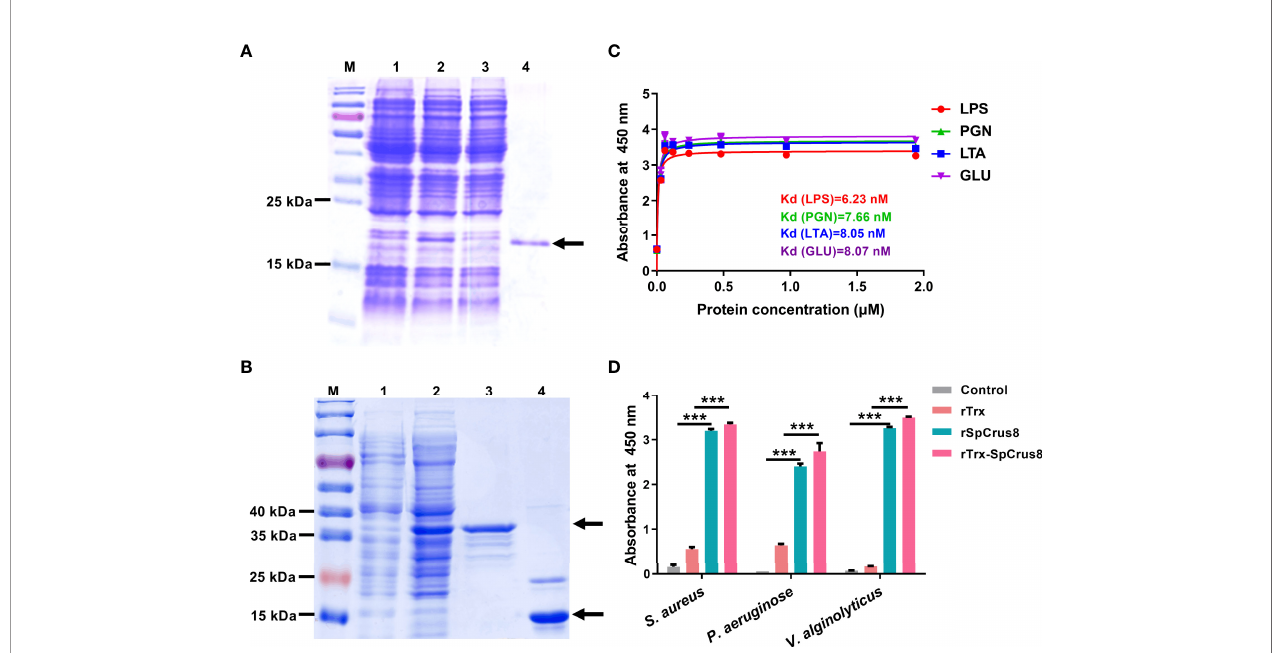
FIGURE 3 | Recombinant SpCrus8 expression and binding activity. Expression and puri fi cation of recombinant SpCrus8. (A) Lane M: protein molecular standard; lane 1: E . coli BL21 (DE3) containing recombinant vector (pET-30a-SpCrus8) before induction; lane 2: E . coli BL21 (DE3) containing recombinant vector (pET-30a- SpCrus8) after induction by 0.5 mM isopropyl- b -D-thiogalactopyranoside (IPTG); lane 3: fl ow-through during protein puri fi cation; lane 4: puri fi ed rSpCrus8. (B) Lane M: protein molecular standard; lane 1: E . coli BL21 (DE3) containing recombinant vector (pET-32a-SpCrus8) before induction; lane 2: E . coli BL21 (DE3) containing recombinant vector (pET-32a-SpCrus8) after induction by 0.5 mM IPTG; lane 3: puri fi ed rTrx-SpCrus8. lane 4: puri fi ed rTrx. (C) Binding activity of rSpCrus8 to PAMPs (LTA for lipoteichoic acid, LPS for lipopolysaccharide, PGN for peptidoglycan, GLU for glucan). (D) Binding activity of rSpCrus8, rTrx-SpCrus8 and rTrx to bacteria ( S. aureus , P. aeruginosa and V. alginolyticus ) and PBS was used as negative control. Signi fi cant difference was indicated with asterisks, ***p <